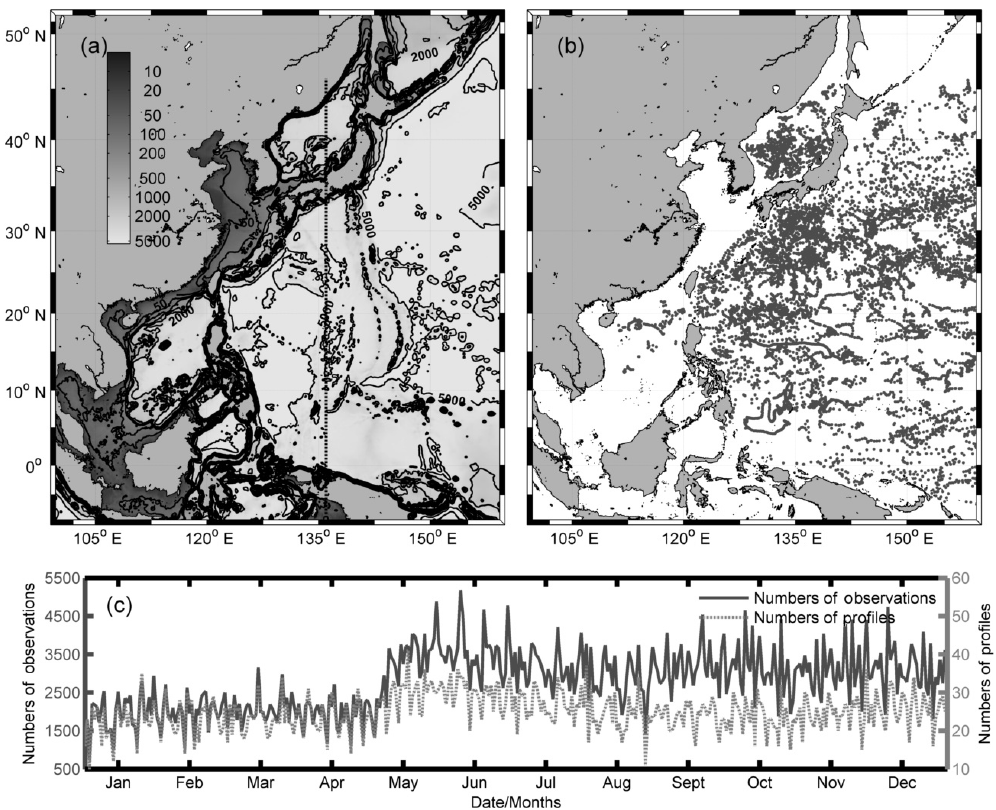
Figure 1. (a) Topography of the model region (depths in meters); the dotted line is the location of the 136 ◦ E section. (b) Horizontal distributions. (c) Temporal evolutions of Argo profiles used in this paper. The black line and the short dashed line represent the number of Argo floats and observations,